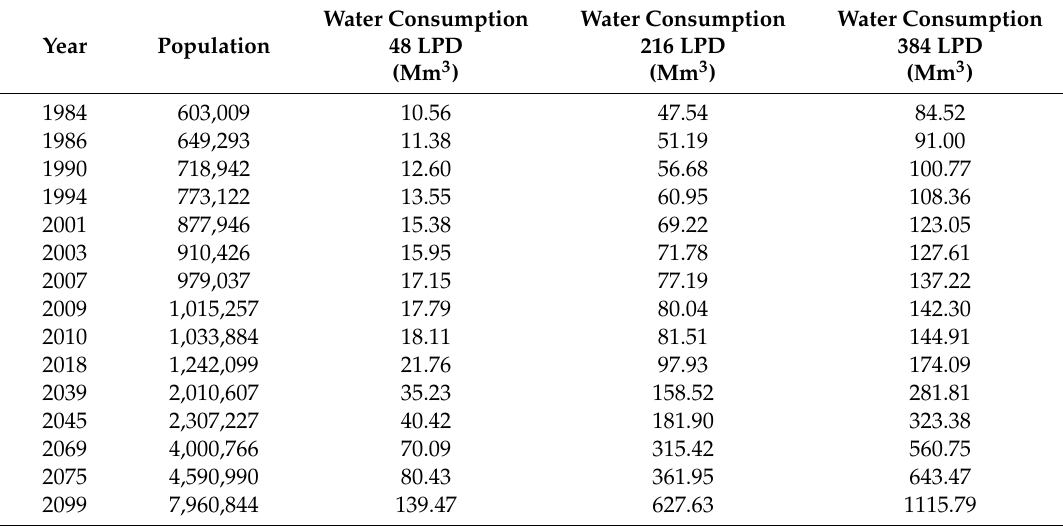
Table 15. Water consumption in the Alto Atoyac